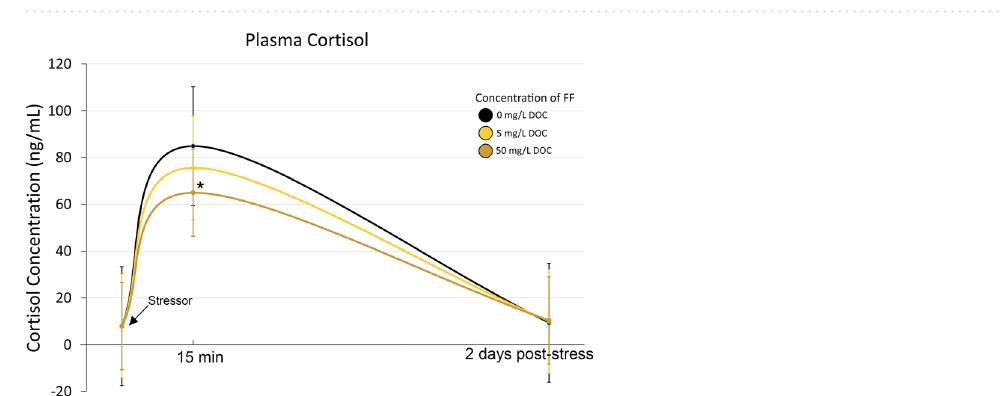
Figure 1. Mean total length (A) and mean weight (B) of juvenile rainbow trout at start and end (28 days) of exposure to FF. Percentages represent gains relative to the start value. *p < 0.05 against control.